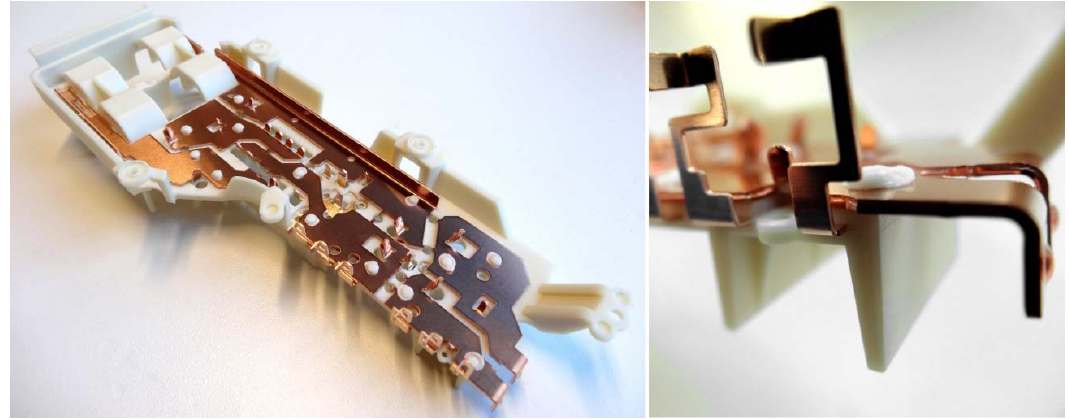
Figure 1. Investigated sample material comprising polybutylene terephthalate and copper.